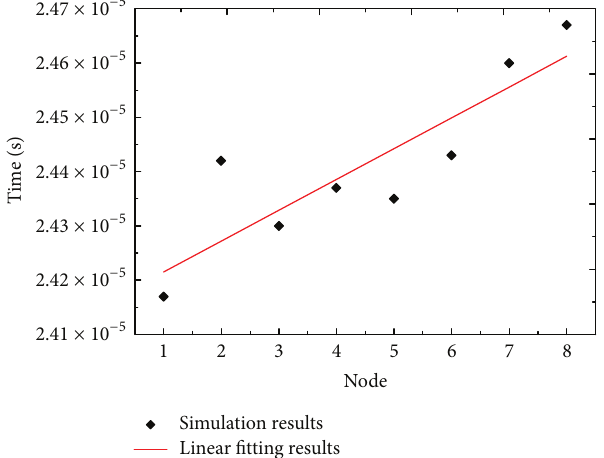
Figure 9: The simulated crack propagation times of node 1 to node 8 and the corresponding linear fitting